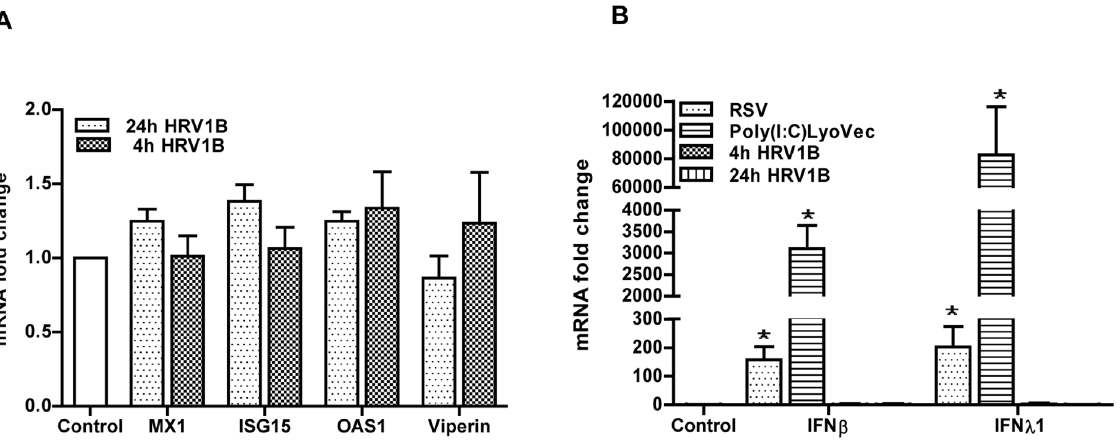
Figure 4. HRV1B induced interferon response in A549. A549 were infected with HRV1B for 4 h and collected after 24 h, or for the whole experimental procedure (n=6). The mRNA expression of ISGs was determined with qPCR and fold changes were calculated with the 2 2 DD Ct method (A). Cells were infected with RSV (MOI-1, 1 h) or HRV1B (4 h). After infection, virus containing medium was removed and replaced with fresh medium. Then cells were collected after 24 h (n=5). While with poly(I:C)/LyoVec (500 ng/ml), cells were collected after 18 h of stimulation (n=3). IFN b / l 1 mRNA expression was determined by qPCR and fold changes were calculated with the 2 2 DD Ct method (B). *, p , 0.05 control vs rest of the conditions.